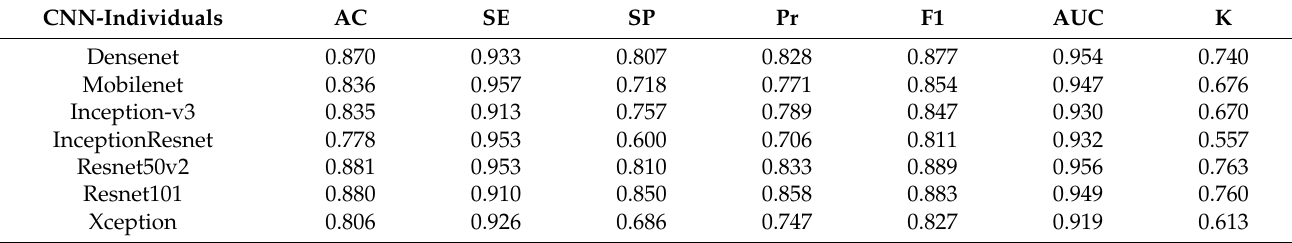
Table 2. Results of individual